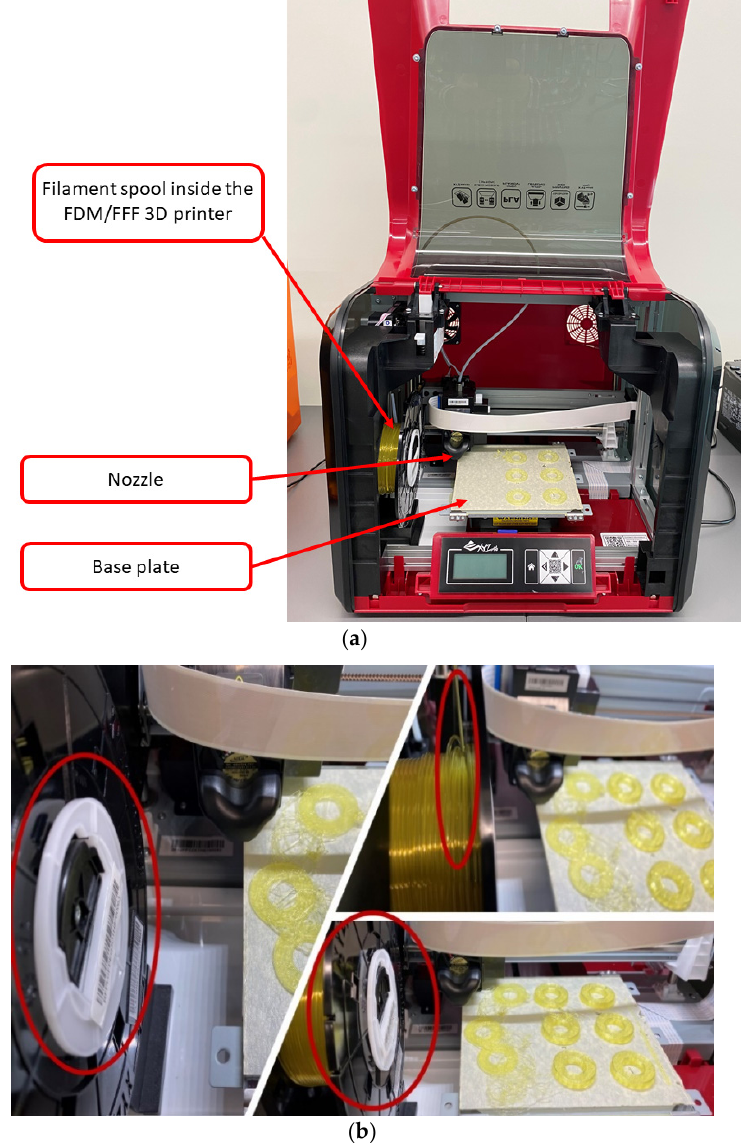
Figure 5. ( a ) Location and arrangement of the filament spool inside the FDM/FFF 3D printer; ( b ) Instability (misalignment) of the filament spool winding (red circles) during the printing process.